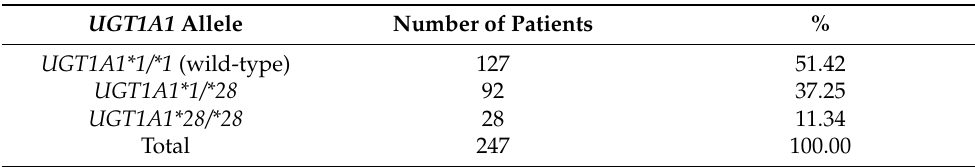
Table 1. UGT1A1 allele frequencies in the whole cohort.